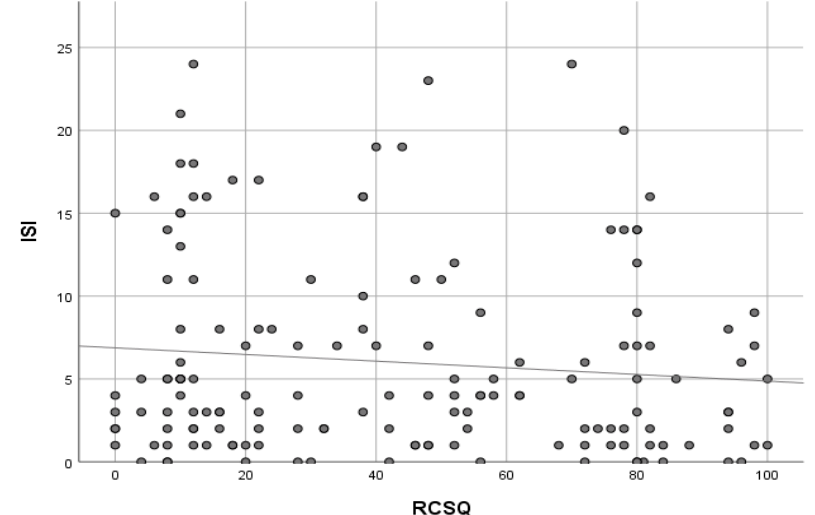
Figure 2. Scatterplot showing the correlation ( r = − 0.1) between baseline clinical insomnia judged by Insomnia Severity Index (ISI) scores and self-reported overnight sleep quality based on Richard Campbell Sleep Questionnaire (RCSQ) scores ( n = 152).